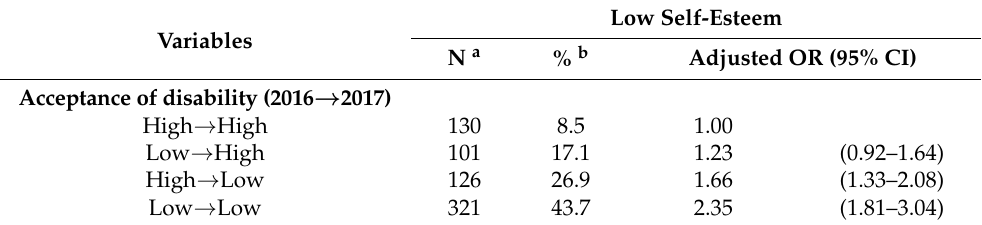
Table 2. Generalized linear model using the GEE with low self-esteem in 2017–2020.